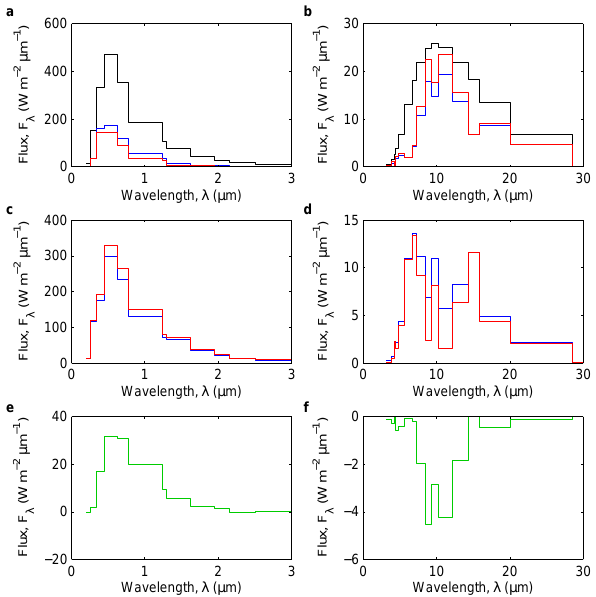
Fig. 6. Comparison of spectrally resolved energy budgets in Real Cloud (RC, blue) and Cloud Free (CF, red) models. Black lines are for both cases. Green is for differences (CF − RC). (a) F ↓ TOA for SW for both cases both cases in black, F ↑ TOA in colours. (b) F ↑ surf LW SW in black, F ↑ TOA in colours. (c) Absorption of solar radiation: A = LW − F ↑ TOA − F ↑ TOA F ↓ TOA (d) greenhouse effect: G = F ↑ surf LW LW SW SW (e) difference in solar absorption: D A = A( CF ) − A( RC) (f) differ- ence in greenhouse effect: D G = G( CF ) − G( RC).